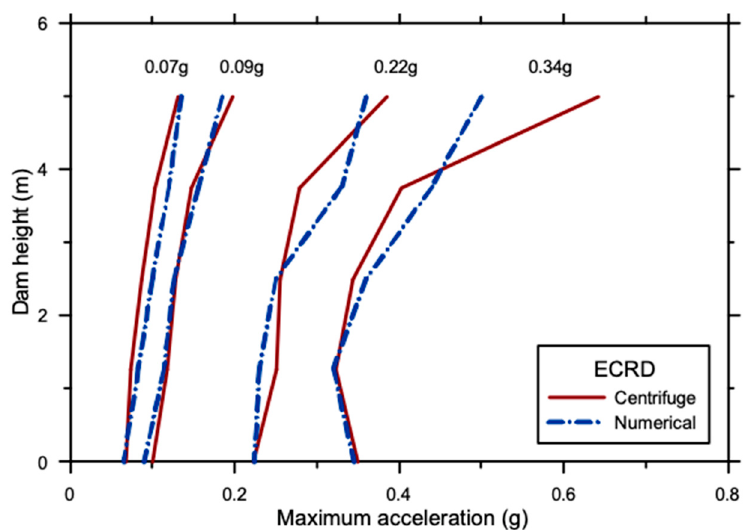
Figure 4. Comparison of measured peak ground acceleration ( PGA ) profiles from centrifuge tests and calculated profiles from 2D dynamic simulations.